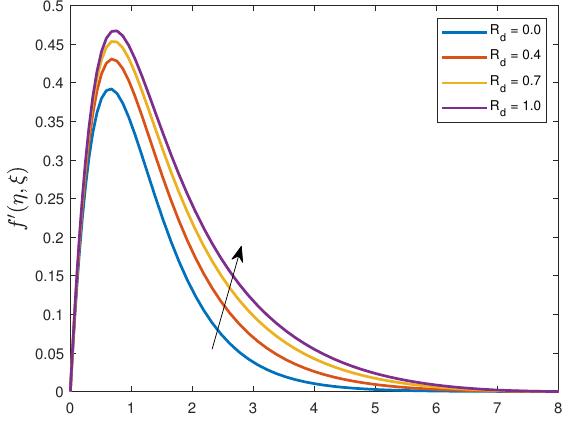
Figure 22. The influence of R d on fluid velocity.